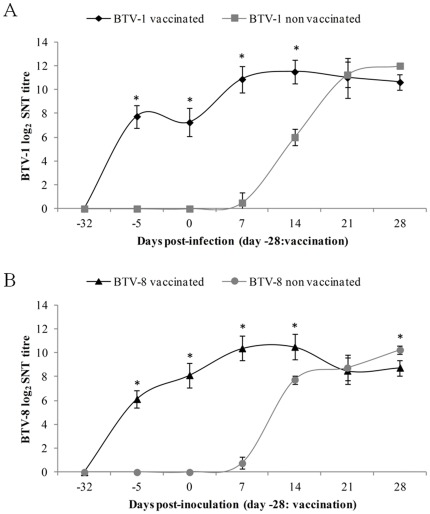
Neutralizing antibody response after BTV vaccination and experimental infection.Evolution of mean BTV-1 (A) and BTV-8 (B) neutralizing antibody titres (with standard deviation) for vaccinated and non vaccinated ibexes.